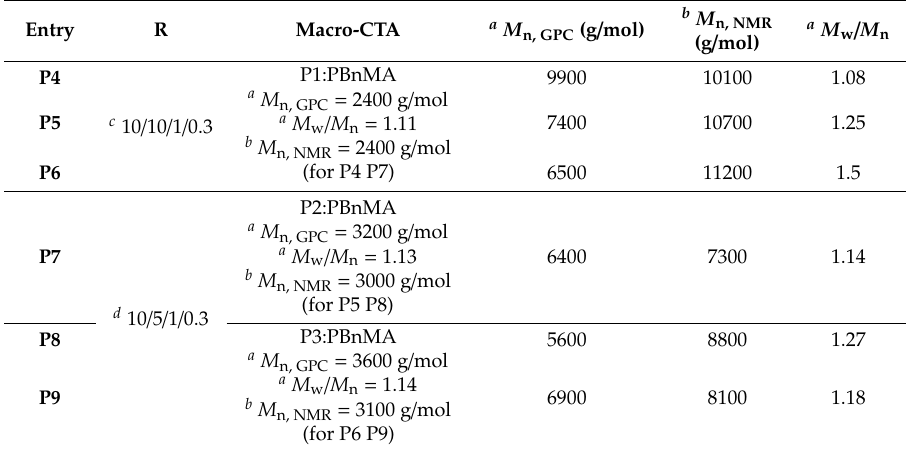
Table 1. Molecular weight and molecular weight distribution of the resultant PBnMA- b -P(BAPMA- co